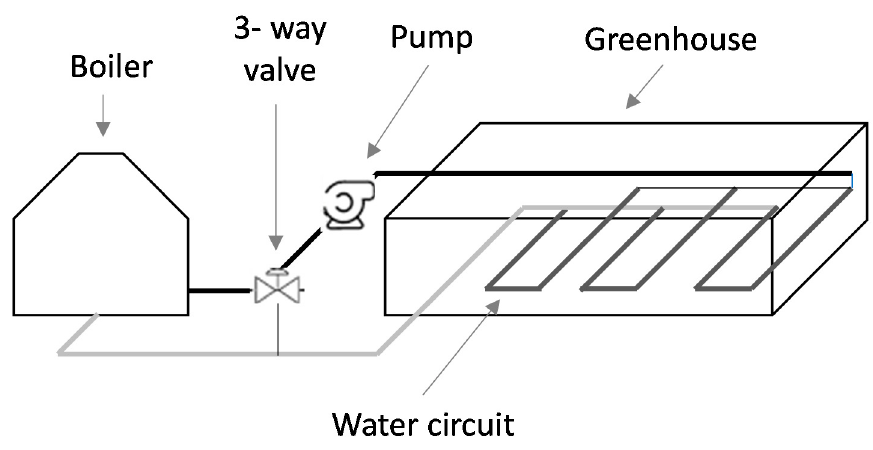
Figure A3. Diagram of the water circuit used for heating.